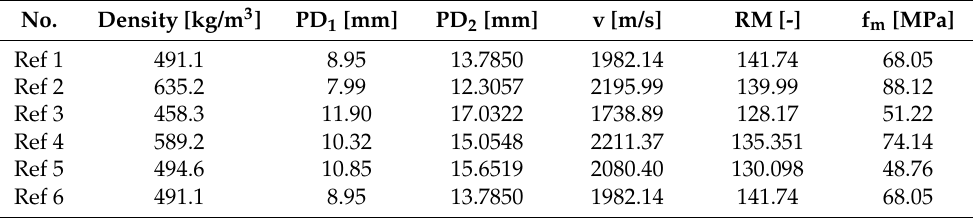
Table 5. Average results of destructive, non-destructive, and semi-destructive tests of reference samples.